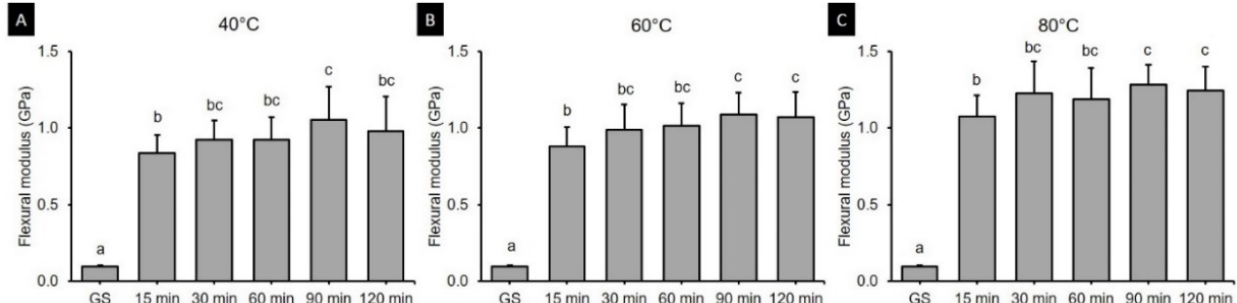
Figure 6. Results from one-way ANOVA. Flexural modulus according to postcuring time for each postcuring temperature. ( A ) 40 °C ( B ) 60 °C and ( C ) 80 °C. Data are mean and standard-deviation values. Different lowercase letters indicate a significant difference in the same group.